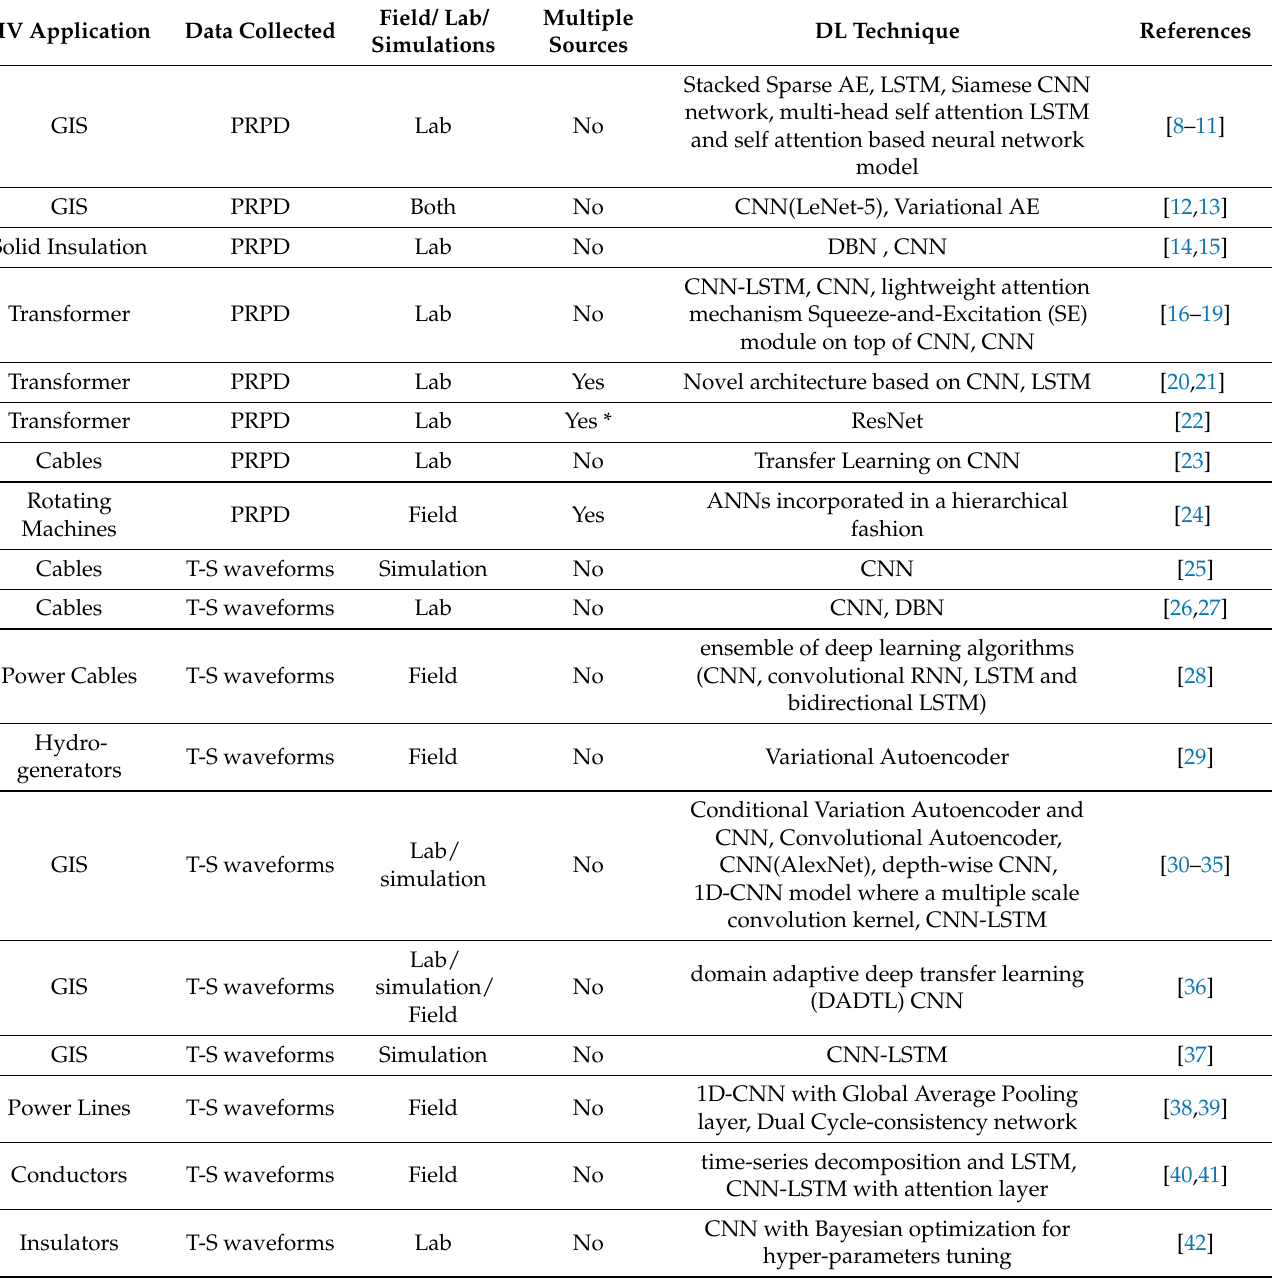
Table 1. Summary of deep learning algorithms used for classification of PD in various HV applica- tions: specification of characteristics of collected data used and whether multiple-labeled sources of PDs are